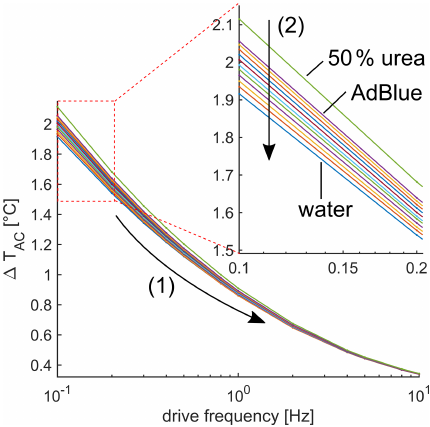
Figure 5. Voltage amplitude V 3 ω as a function of drive frequency. (1) Voltage V 3 ω monotonically decreases for increasing drive fre- quency. Zoomed cutout: (2) the signal decreases if the urea concen- tration decreases.